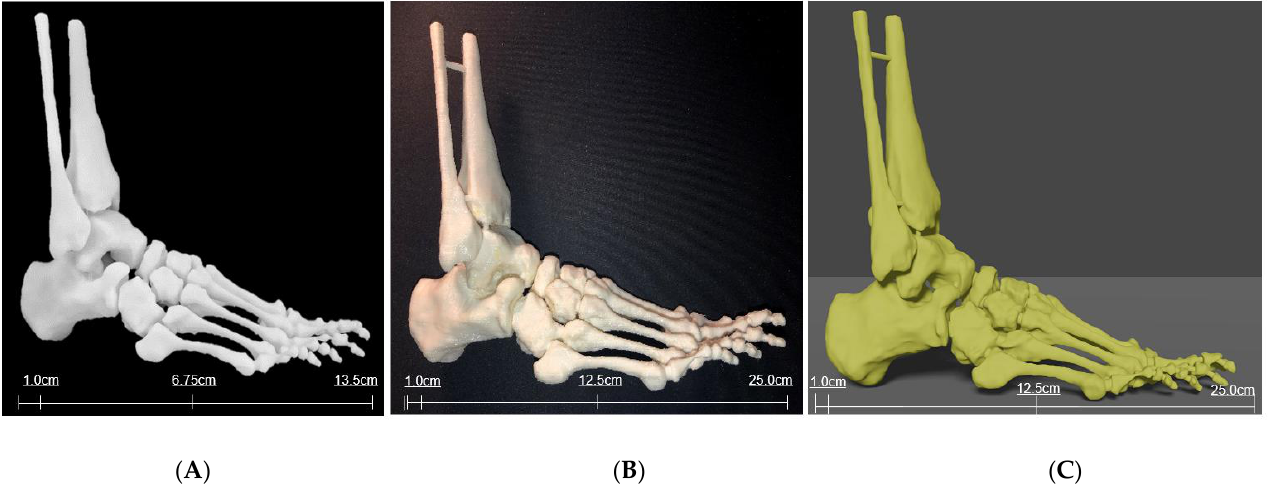
Figure 9. Three-dimensional printed models of foot and ankle bony anatomy in white acrylic resin ( A ) using Formlabs 3D printer (Massachusetts, USA) and TPU ( B ) and PLA ( C ) using Ultimaker 2 Extended 3D printer (Ultimaker BV, Geldermalsen, the Netherlands).